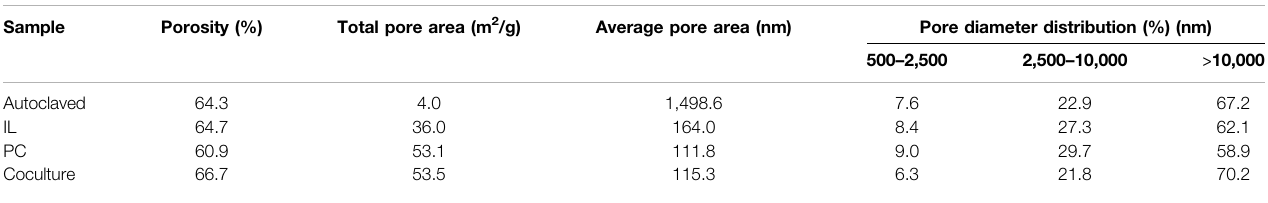
TABLE 2 | Mercury intrusion porosimetry results of alkali lignin samples.